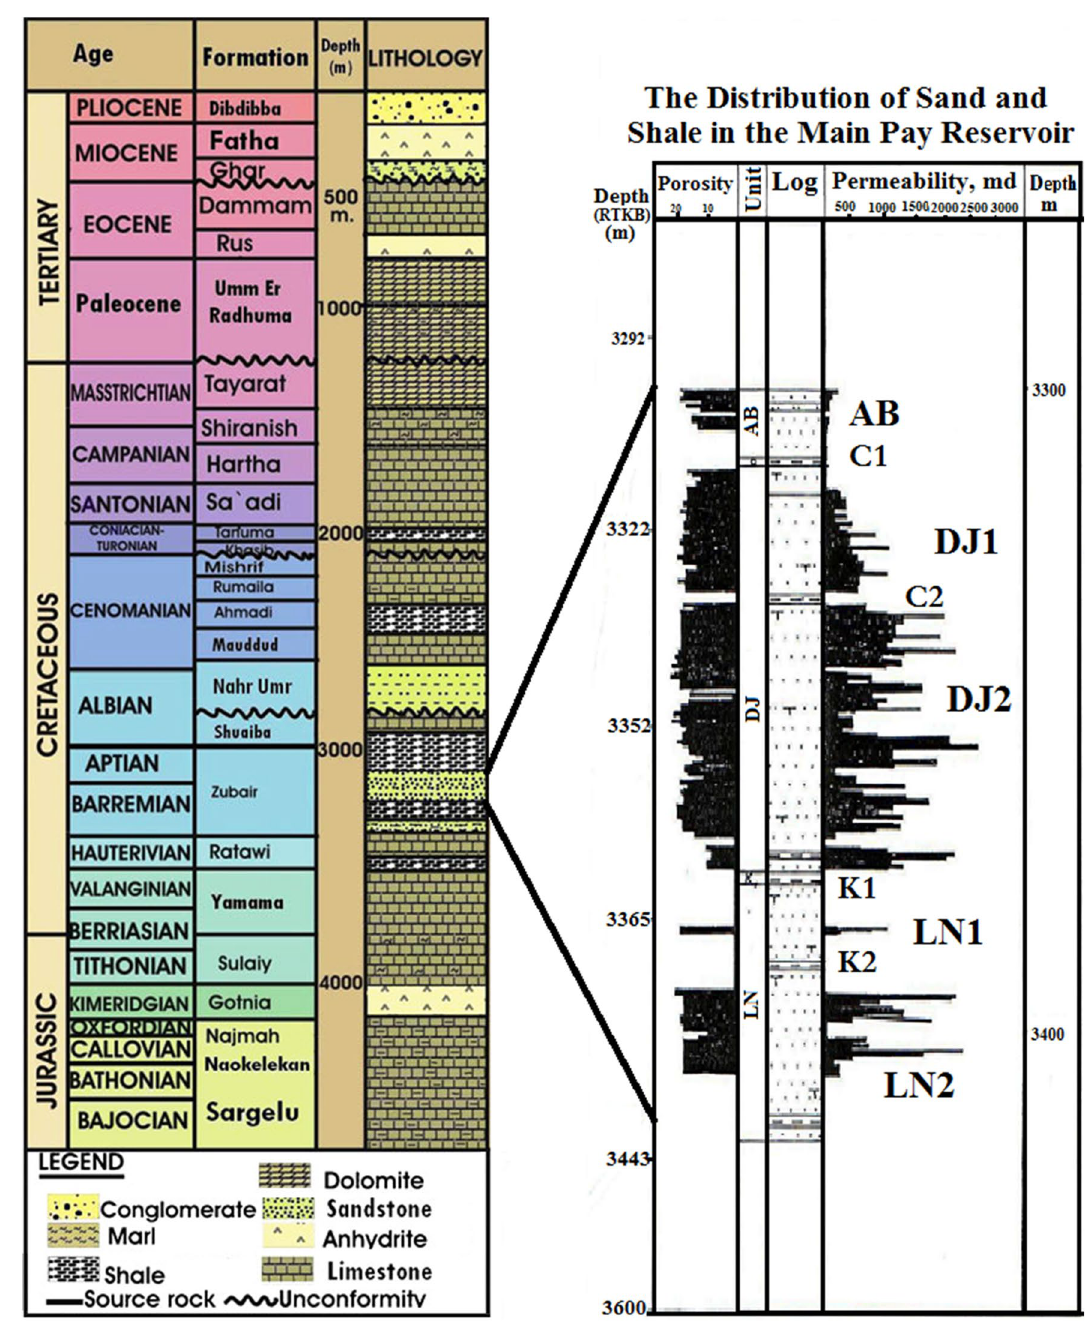
Fig. 1 Stratigraphic column of South Rumaila oil field. Modified from Al-Ameri et al. (2009) and Mohammed et al.